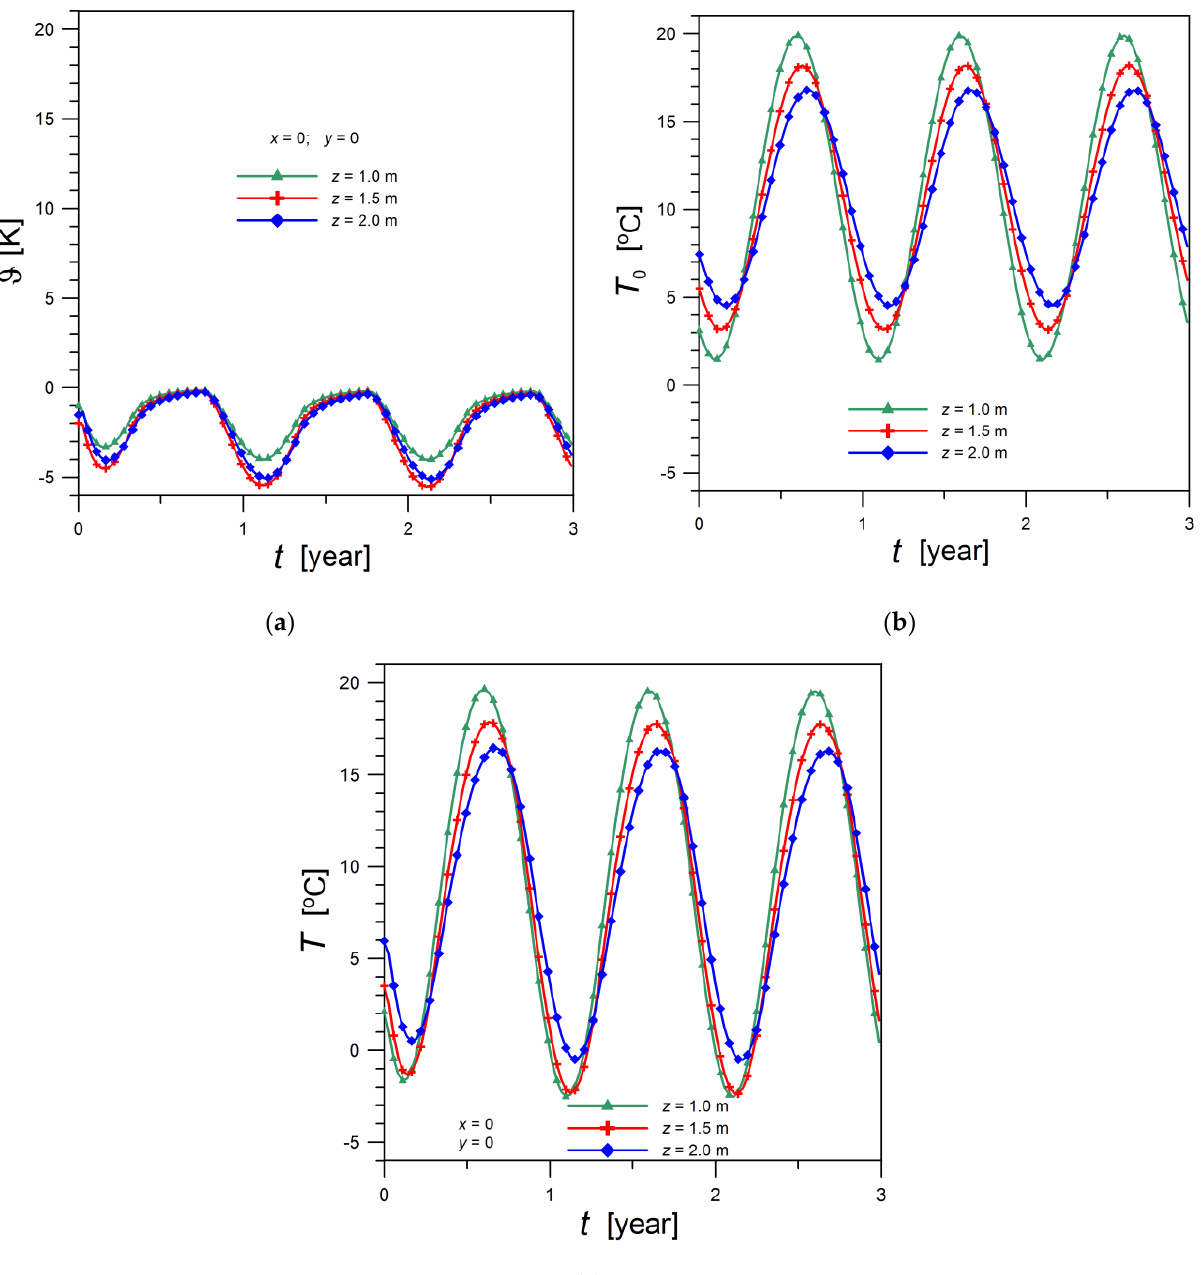
Figure 9. Dependence of ground temperature at a given point in time: ( a ) temperature response caused by the heat source, ( b ) undisturbed ground temperature, ( c ) ground temperature.